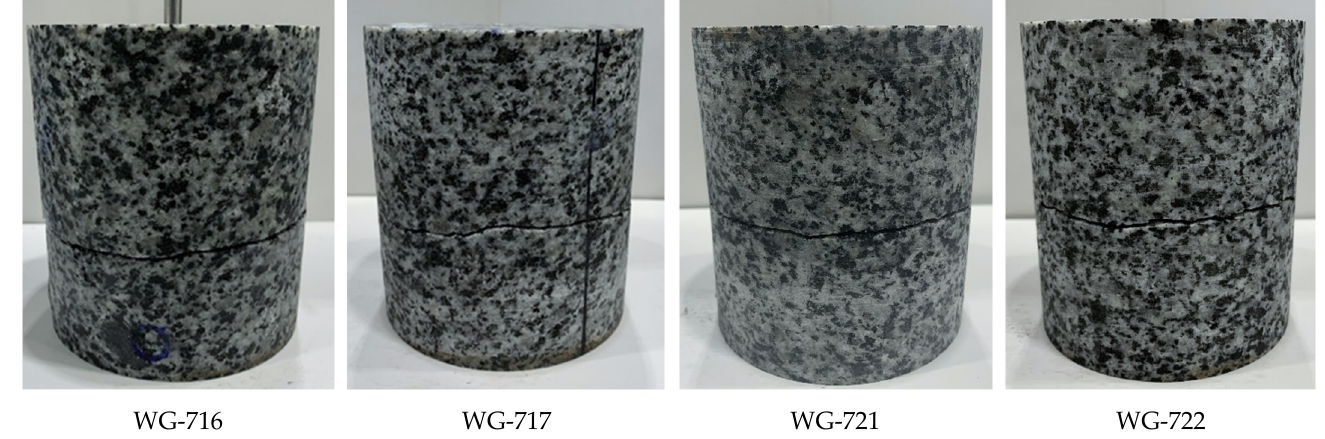
Figure 18. The specimens WG716, WG717, WG721, and WG722 after the experiment.